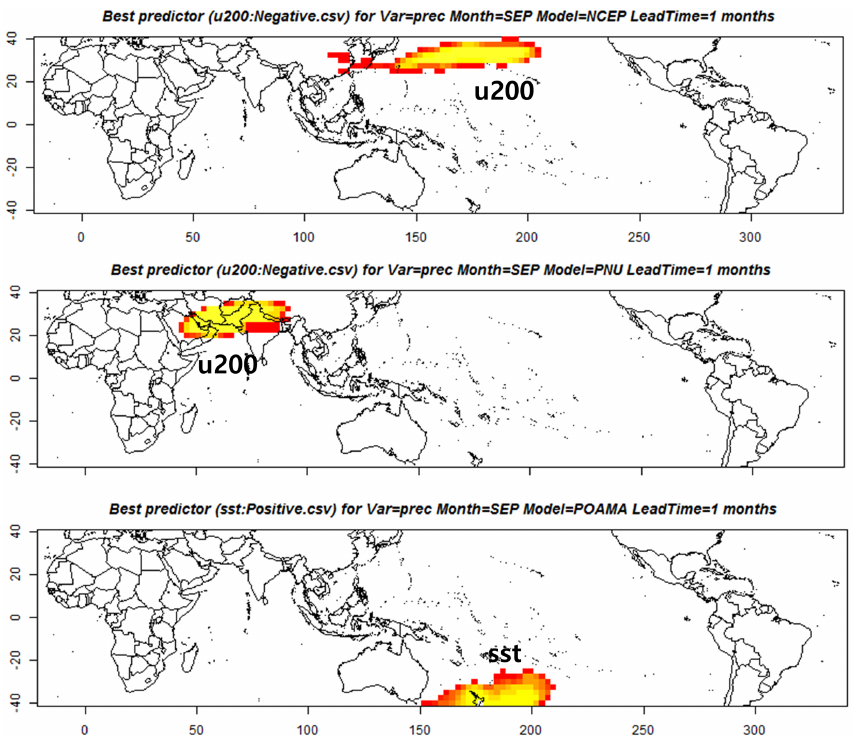
Figure 3. Spatial distribution of selected variables by the NCEP, PNU, and POAMA models for 1-month lead precipitation predictions in September (yellow indicates most frequent selection through the cross-validation procedures from 1983 to 2013).